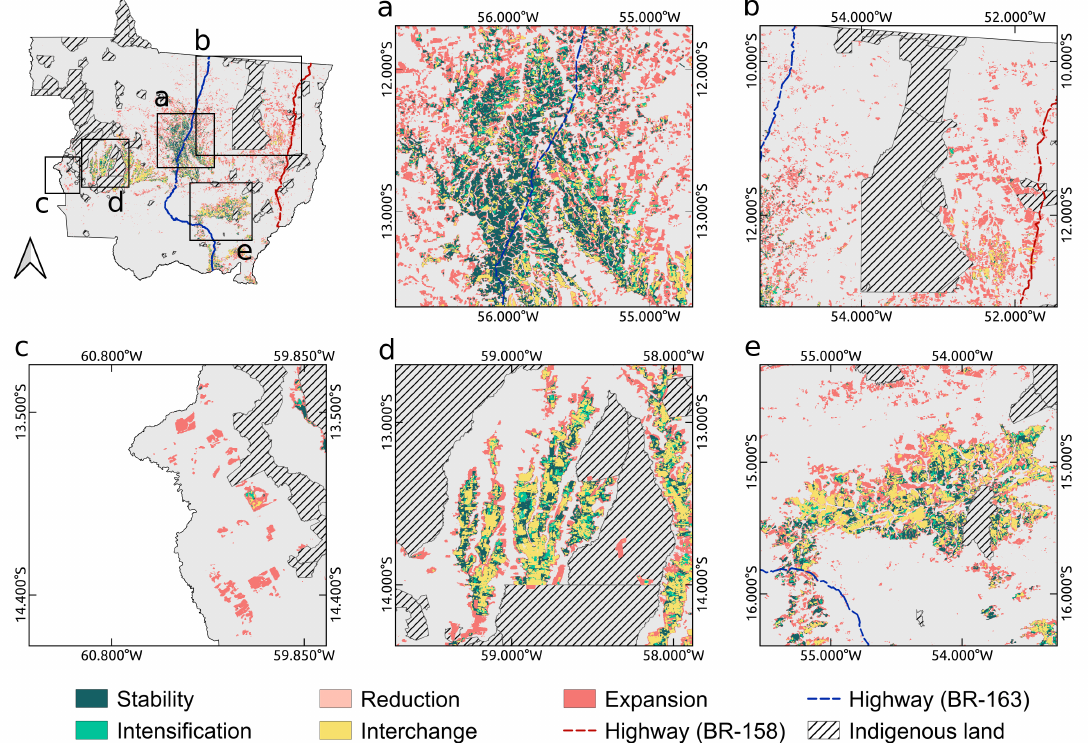
Figure 7. Patterns of agricultural practice trajectories in Mato Grosso State, from 2001 to 2017. ( a ) Traditional agricultural area, a region of the Sinop municipality (border between the Amazon and Cerrado biomes); ( b ) Xingu Indigenous Park region (Amazon biome); ( c ) agricultural expansion area, west of the Mato Grosso State (Amazon biome); ( d ) traditional agricultural area (Cerrado biome); ( e ) traditional agricultural area, south of the Mato Grosso State (Cerrado